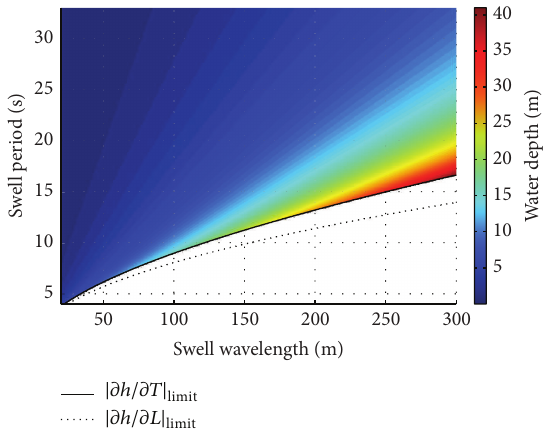
Figure 5: Swell wavelengths and periods which provide |𝜕ℎ/𝜕𝐿| = |𝜕ℎ/𝜕𝐿| (dotted line) and |𝜕ℎ/𝜕𝑇| = |𝜕ℎ/𝜕𝑇| limit line) together with the water depths calculated from the linear dispersion relation in the considered admissible area of the (𝐿,𝑇) plane.